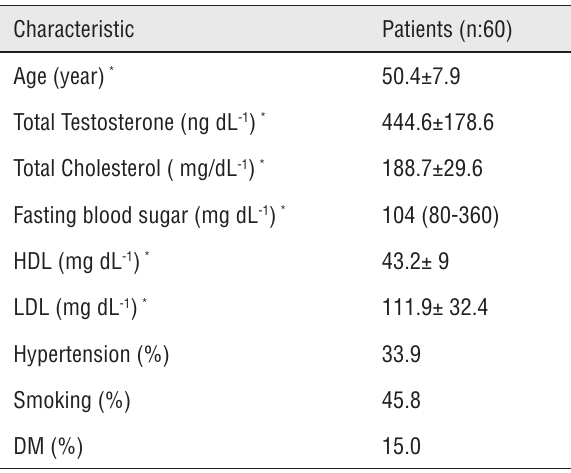
Table 1 - Clinical data and fasting endocrine values of the